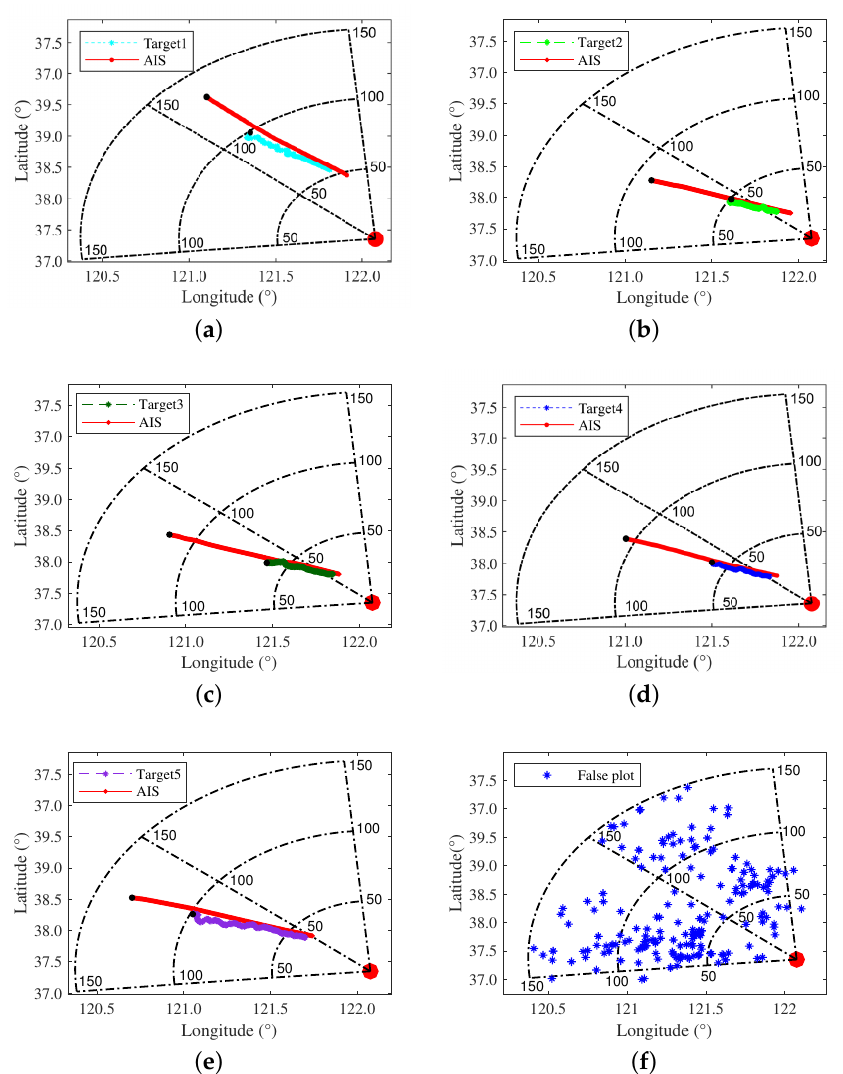
Figure 9. Tracks of five selected moving vessels and the selected false plots in geographic coordinate system. ( a ) Target 1. ( b ) Target 2. ( c ) Target 3. ( d ) Target 4. ( e ) Target 5. ( f ) False plots. The solid red dots indicate the radar